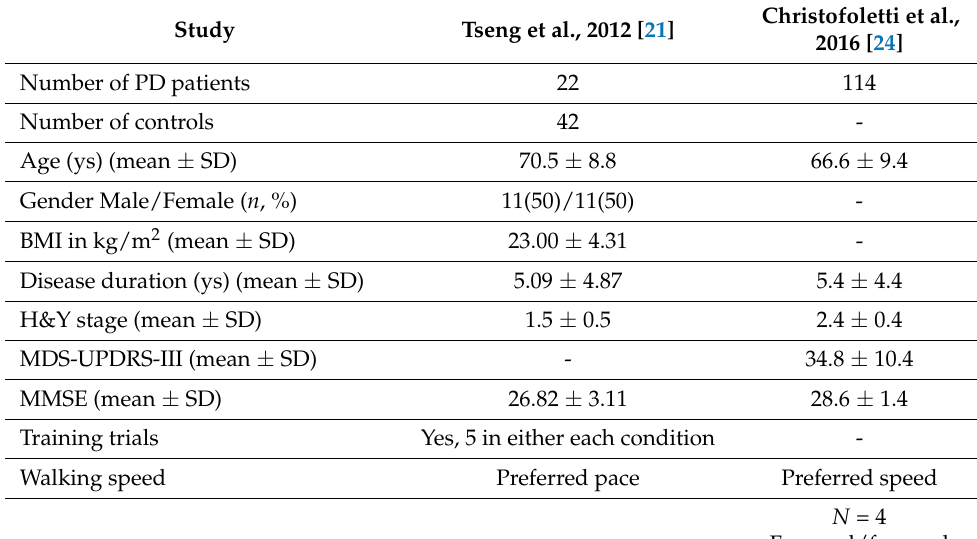
Table 1. Characteristics of persons with Parkinson’s disease (PD) and summary of walking conditions used in the included